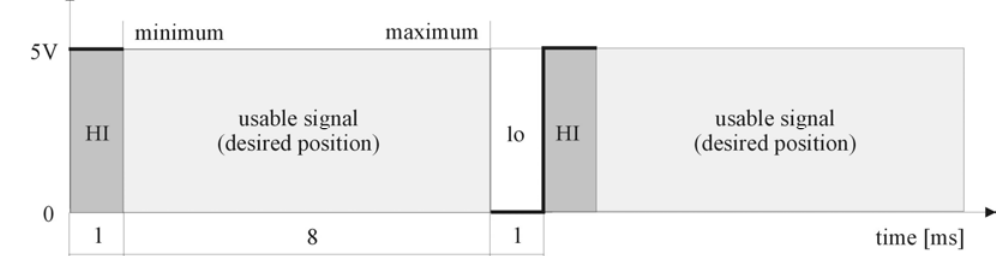
Fig 4. SPS-1 control system equipped with set of EMA: EMH1/H2/L/V/T – electro-mechanical units, CTRH1/H2/L/V/T – actuator controllers, H – elevator, L – aileron, V – rudder, T – throttle